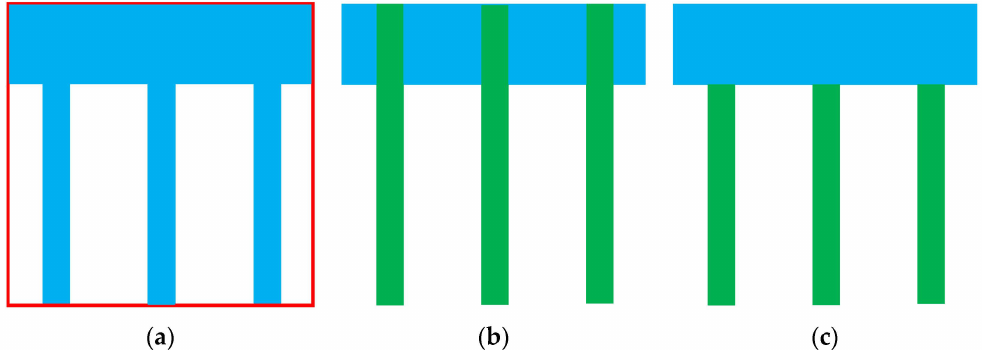
Figure 7. Segmented planar feature—in light blue—and the encompassing MBR—in red ( a ); segmented linear features—in green ( b ); and final segmentation after the identification of partially-misclassified linear features ( c